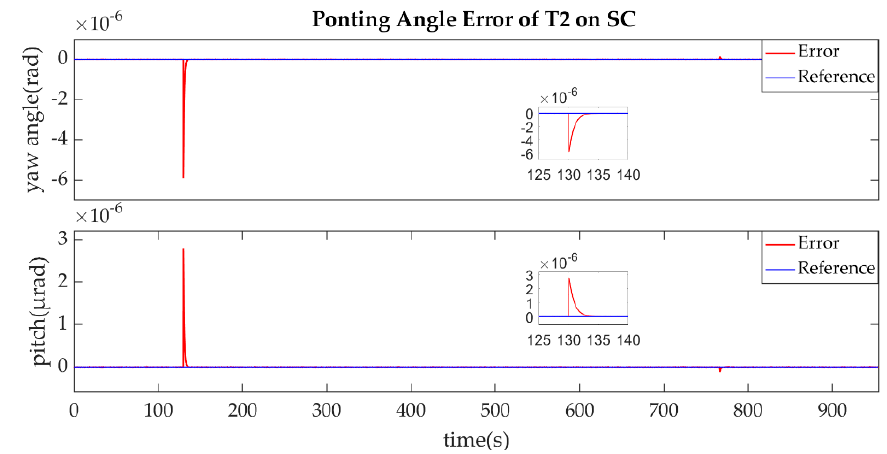
Figure 13. Pointing Angle of T2 on SC.